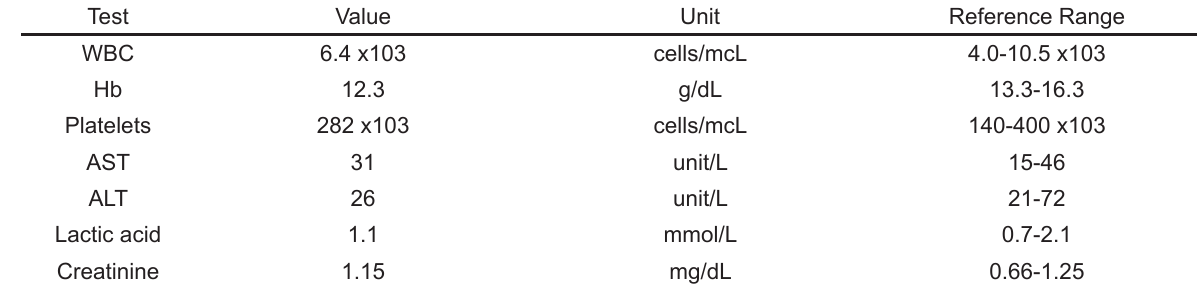
Table. Laboratory values obtained in the emergency department.